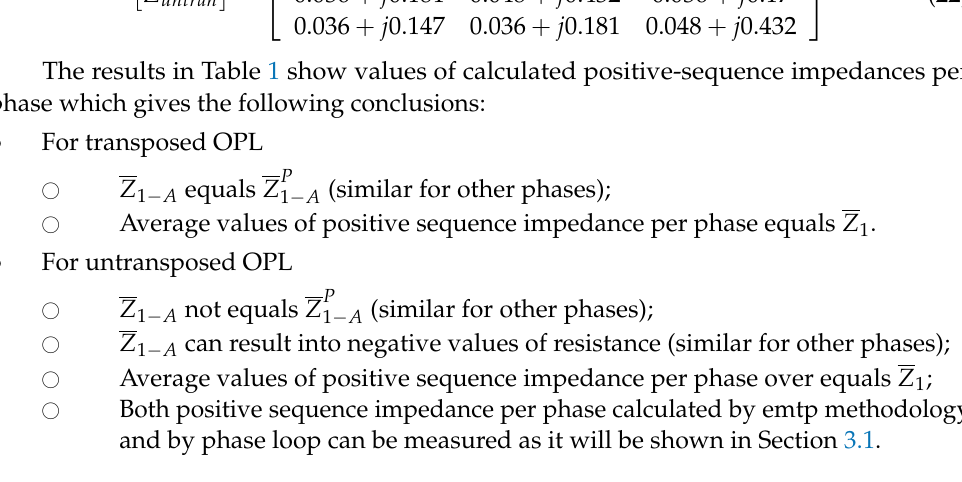
Table 1. Results of positive sequence impedances per phase calculated by two different approaches for transposed and untransposed